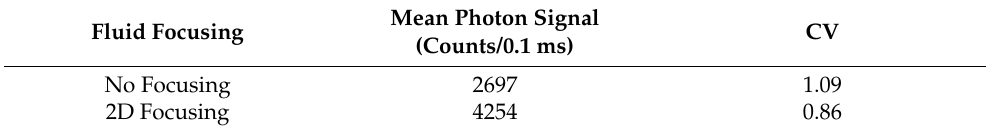
Table 3. Mean and CV for a biosensor illuminated by a line laser.